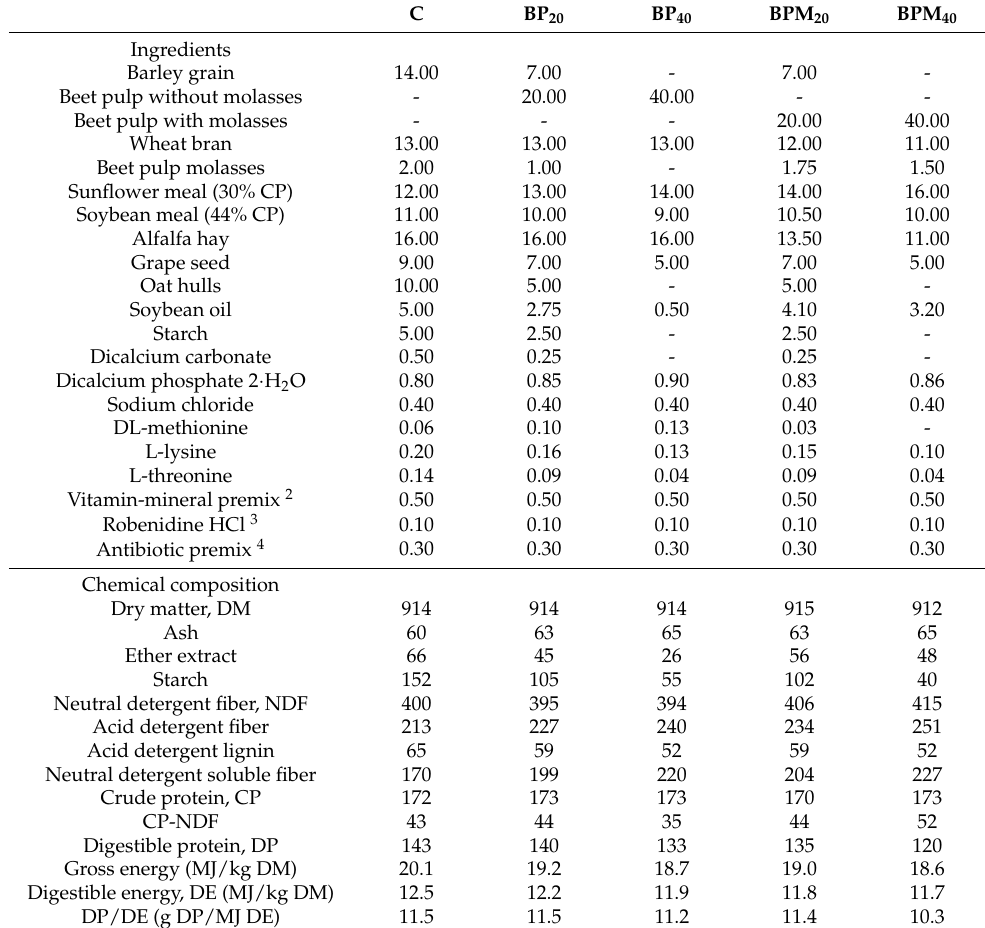
Table 1. Ingredients (%) and chemical composition (g/kg DM) of the experimental diets 1